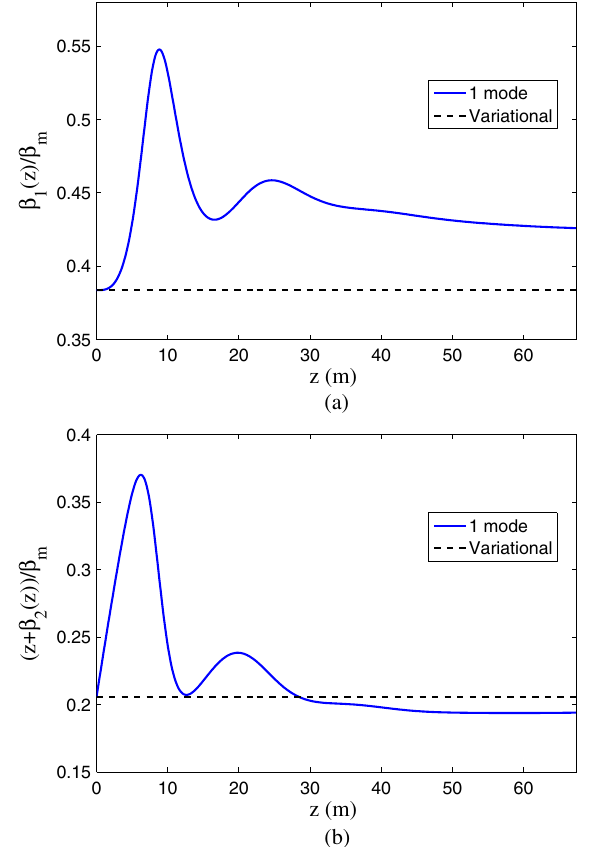
FIG. 3. Single-mode data for (a) the local Rayleigh length and (b) the real part of the radiation complex beam parameter in units (blue curves). The dashed lines are the corresponding of (cid:7) m eigenmode. variational values for the E 00